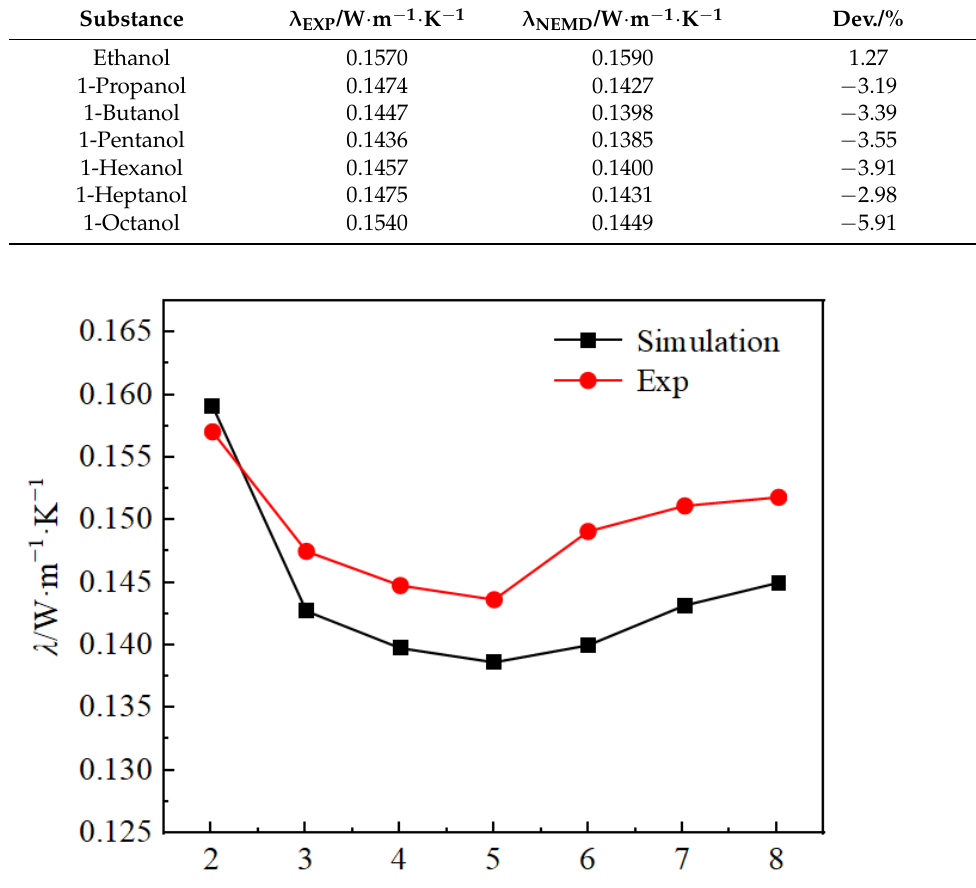
Figure 3. Comparison between experimental and simulated values of thermal conductivity for seven species of alcohols at 323.15 K.